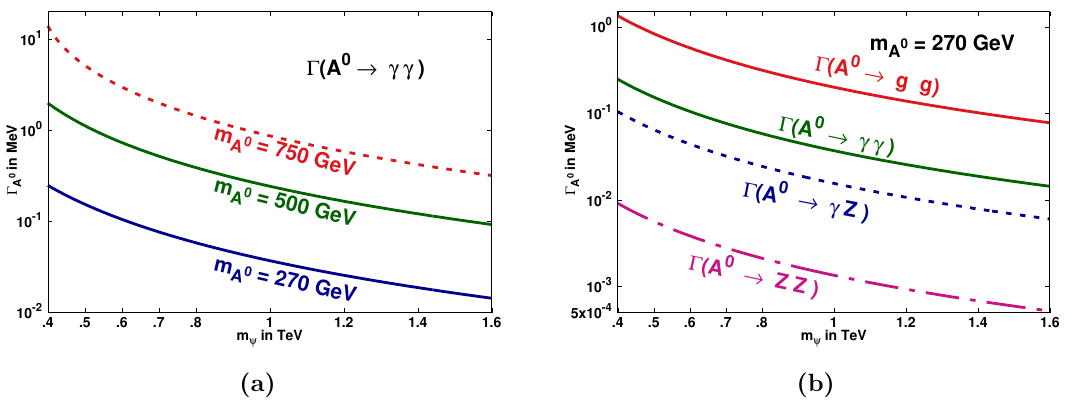
Figure 3. Figure 3a, depicts the variation of the partial decay-widths of the pseudo-scalar with the VLQ mass